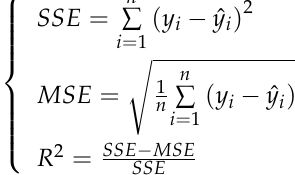
where y i and ˆ y i are the ideal value sampling points represented by the red curve and the simulation effect value sampling points represented by the black curve in Figure